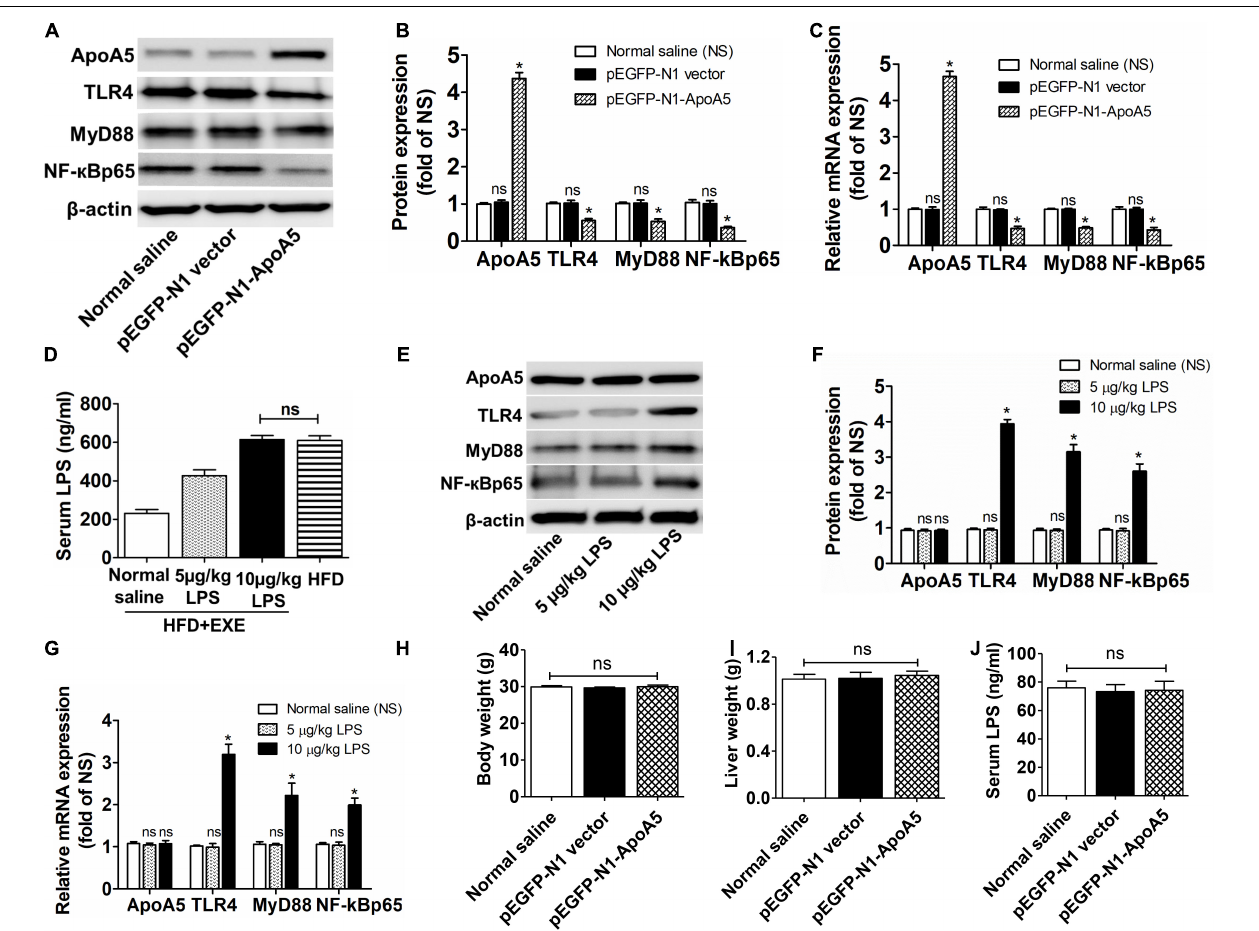
FIGURE 3 | Exercise enhanced the ability of ApoA5 to inhibit TLR4 signaling pathway by lowering LPS concentrations. The hepatic protein (A,B) and relative mRNA (C) expression levels of ApoA5, TLR4, MyD88, and NF- κ Bp65 in LFD mice transfected with pEGF-N1-ApoA5. The LPS levels of serum in HFD + EXE mice after injection of different concentrations of LPS (D) . The hepatic protein (E,F) and relative mRNA (G) expression levels of ApoA5, TLR4, MyD88, and NF- κ Bp65 in HFD + EXE mice after injection of different concentrations of LPS. The body weight (H) , liver weight (I) , and circulating LPS concentrations (J) in LFD mice transfected with pEGF-N1-ApoA5. Results are presented as the mean ± SEM, n = 4 per group. * P < 0.05 for different from the pEGF-N1 vector group or 5 µ g/kg · wt group; ns P > 0.05 (no difference) for different from the normal saline